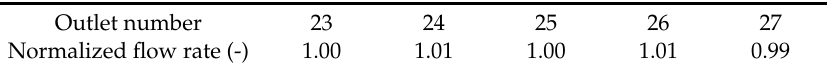
Table 4. Evaluation result of flow uniformity of the SRFD